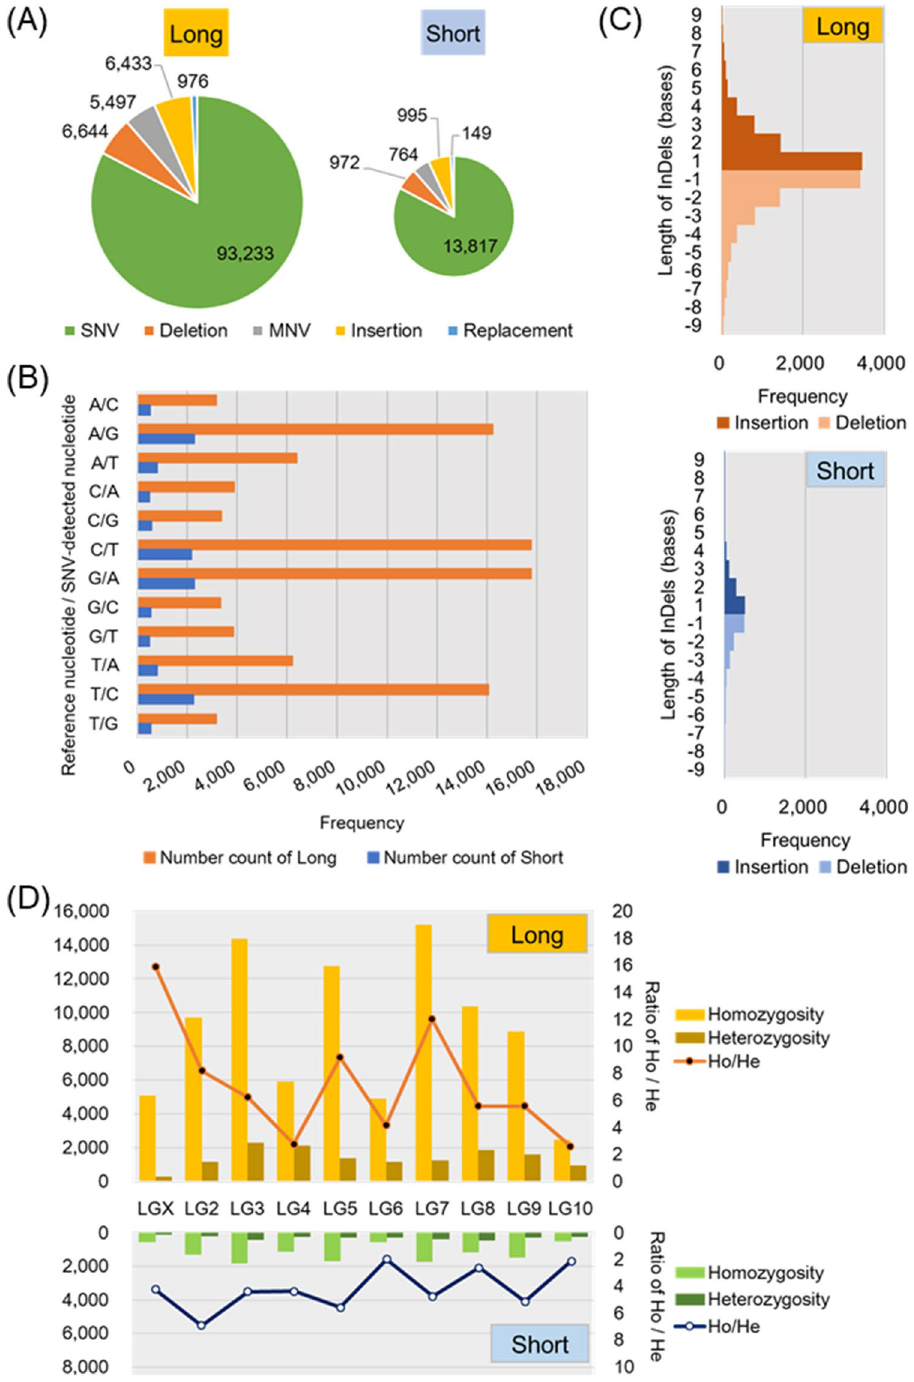
Figure 1. Analytical results of small variants of DNA sequence in a whole genome level in long and short strains. Proportion of small variants as SNV, MNV, deletion, insertion, and replacement in long and short strains ( A ). The numbers of small variants are indicated as the diameter of a pie graph. Frequencies of the SNVs in both long and short strains were compared with the reference nucleotide ( B ). Insertion and deletion ranged from one to nine bases in both long and short strains ( C ). Frequency of homozygosity or heterozygosity and its ratio in all linkage groups in long and short strains ( D